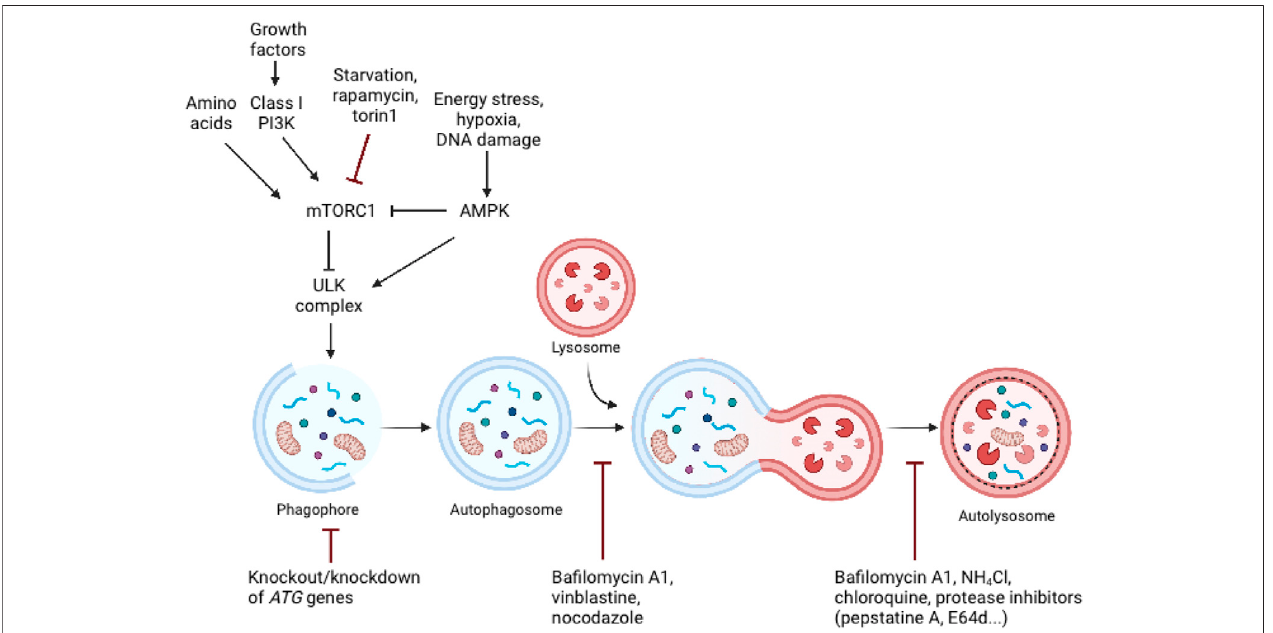
FIGURE 2 | Schematic representation of major signalling pathways that regulate autophagy and the inhibition of autophagy by genetic and pharmacological approaches. Autophagy is controlled by a variety of growth and nutrition signaling pathways. mTORC1 activity, which re fl ects cellular nutritional status, is a major regulator ofautophagy. Since the ULK complexis inactivated bymTORC1activity, suf fi cient amounts ofamino acids and growth hormonespreventautophagy. Cellular stress, such as energy deprivation, DNA damage, and hypoxia inhibit mTORC1 activity, resulting in the release and activation of the ULK complex, which triggers autophagosome formation. Adapted from